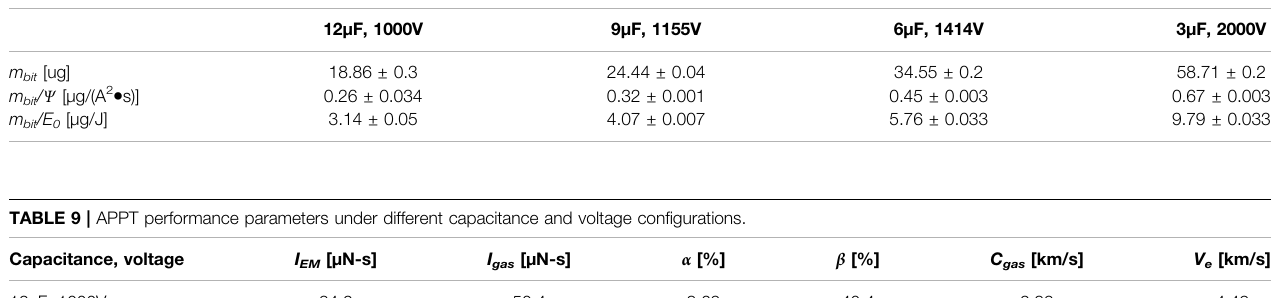
TABLE 8 | Ablation characteristics of propellant under different capacitance and voltage con fi gurations.